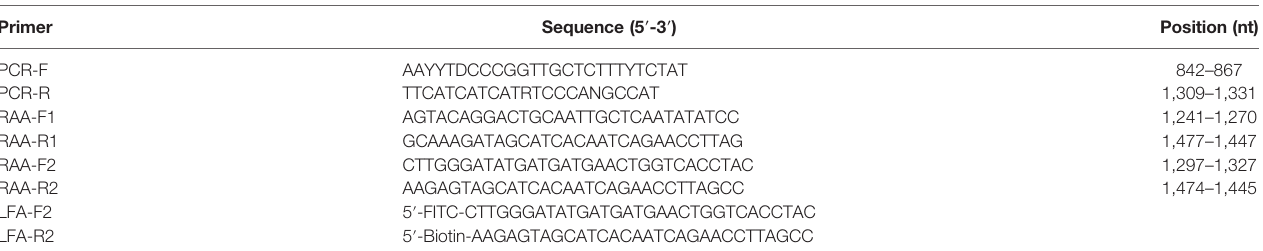
TABLE 1 | Primer sequences used in this study.